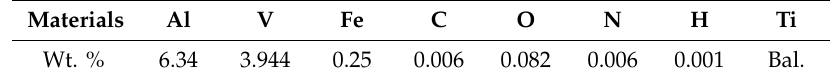
Table 2. Chemical composition of TLS Technik GmbH Ti6Al4V (ELI) alloy powder (wt.